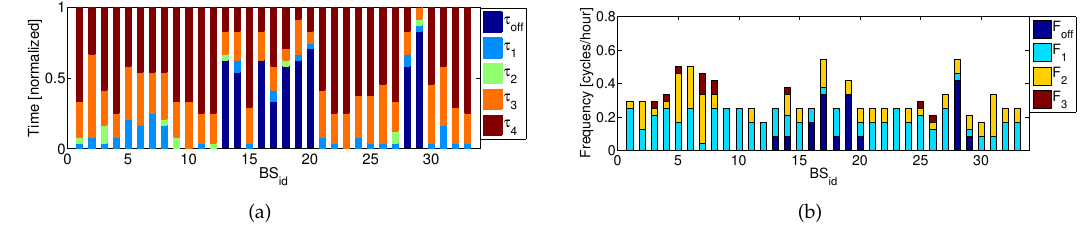
Figure 4. Normalized time spent in each power state and frequency of power transitions. ( a ) Normalized time spent in each power state; ( b ) frequency of power transitions.